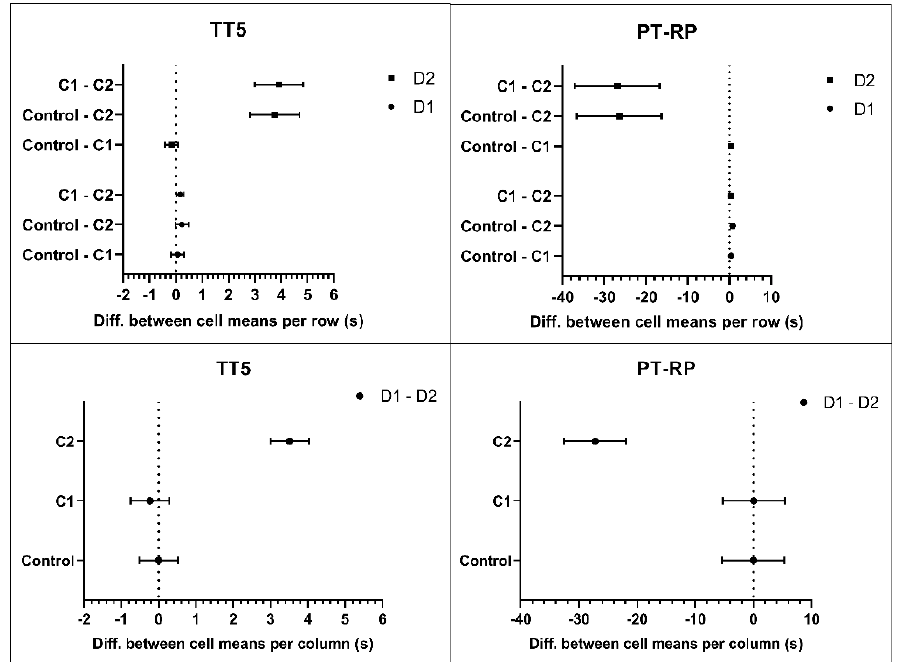
Figure 3. Changes in coagulation parameters expressed as differences in one factor within the levels of the other factor. The upper plots show simple main effects of concentration, and the lower plots the effect of generation. The symbols denote mean responses with 95% CI. Abbreviations: TT5, thrombin time; PT − RP, prothrombin time (RP, recombiplastine). Note: changes in APTT − SS—activated partial thromboplastine time (reagent: SynthA Sil) followed the same pattern as those for PT-RP .